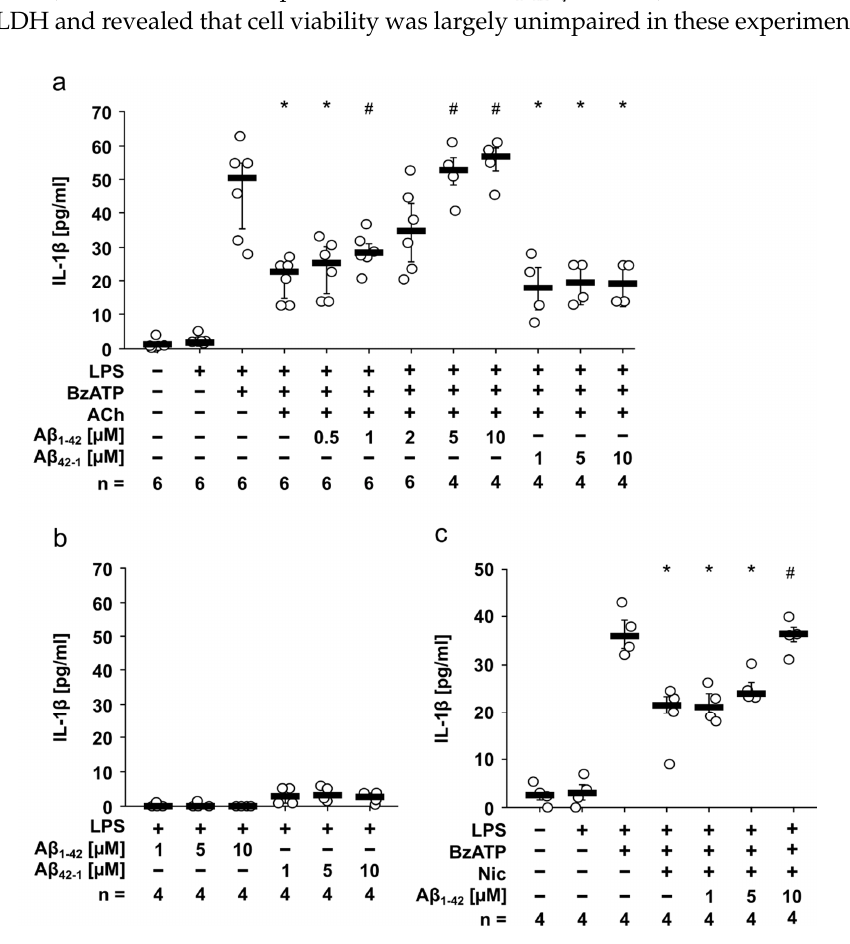
Figure 1. Amyloid beta peptide (A β 1-42 ) reverses the inhibitory effect of acetylcholine (ACh) and nicotine (Nic) on BzATP-induced interleukin-1 β (IL-1 β ) release by human monocytic U937 cells. U937 cells were primed with lipopolysaccharide (LPS) from Escherichia coli for 5 h. Thereafter, the P2X7 receptor agonist 2(3)-O-(4-benzoylbenzoyl)adenosine-5-triphosphate (BzATP; 100 µM) was added for another 30 min and IL-1 β was measured by ELISA in cell culture supernatants. ( a ) The nicotinic agonist ACh (7.5 µM) inhibited the BzATP-induced release of IL-1 β . This inhibitory effect was dose dependently blunted by A β 1-42 with an IC 50 = 2.54 µM. Reverse A β 42-1 (1–10 µM) had no impact. ( b ) In control experiments, neither A β 1-42 nor A β 42-1 induced changes in IL-1 β release by LPS-primed U937 cells. ( c ) The inhibitory e ff ect of Nic (10 µ M) was blunted in presence of 10 µ M A β 1-42 . All data are shown as individual data points, bar represents median, whiskers encompass the 25th to 75th percentile. Statistical analyses were performed using the Kruskal–Wallis followed by Mann–Whitney U test. * p ≤ 0.05, di ff erent from LPS-primed cells stimulated with BzATP alone. # p ≤ 0.05, di ff erent from LPS-primed cells stimulated with BzATP and the corresponding nicotinic agonist without A β 1-42